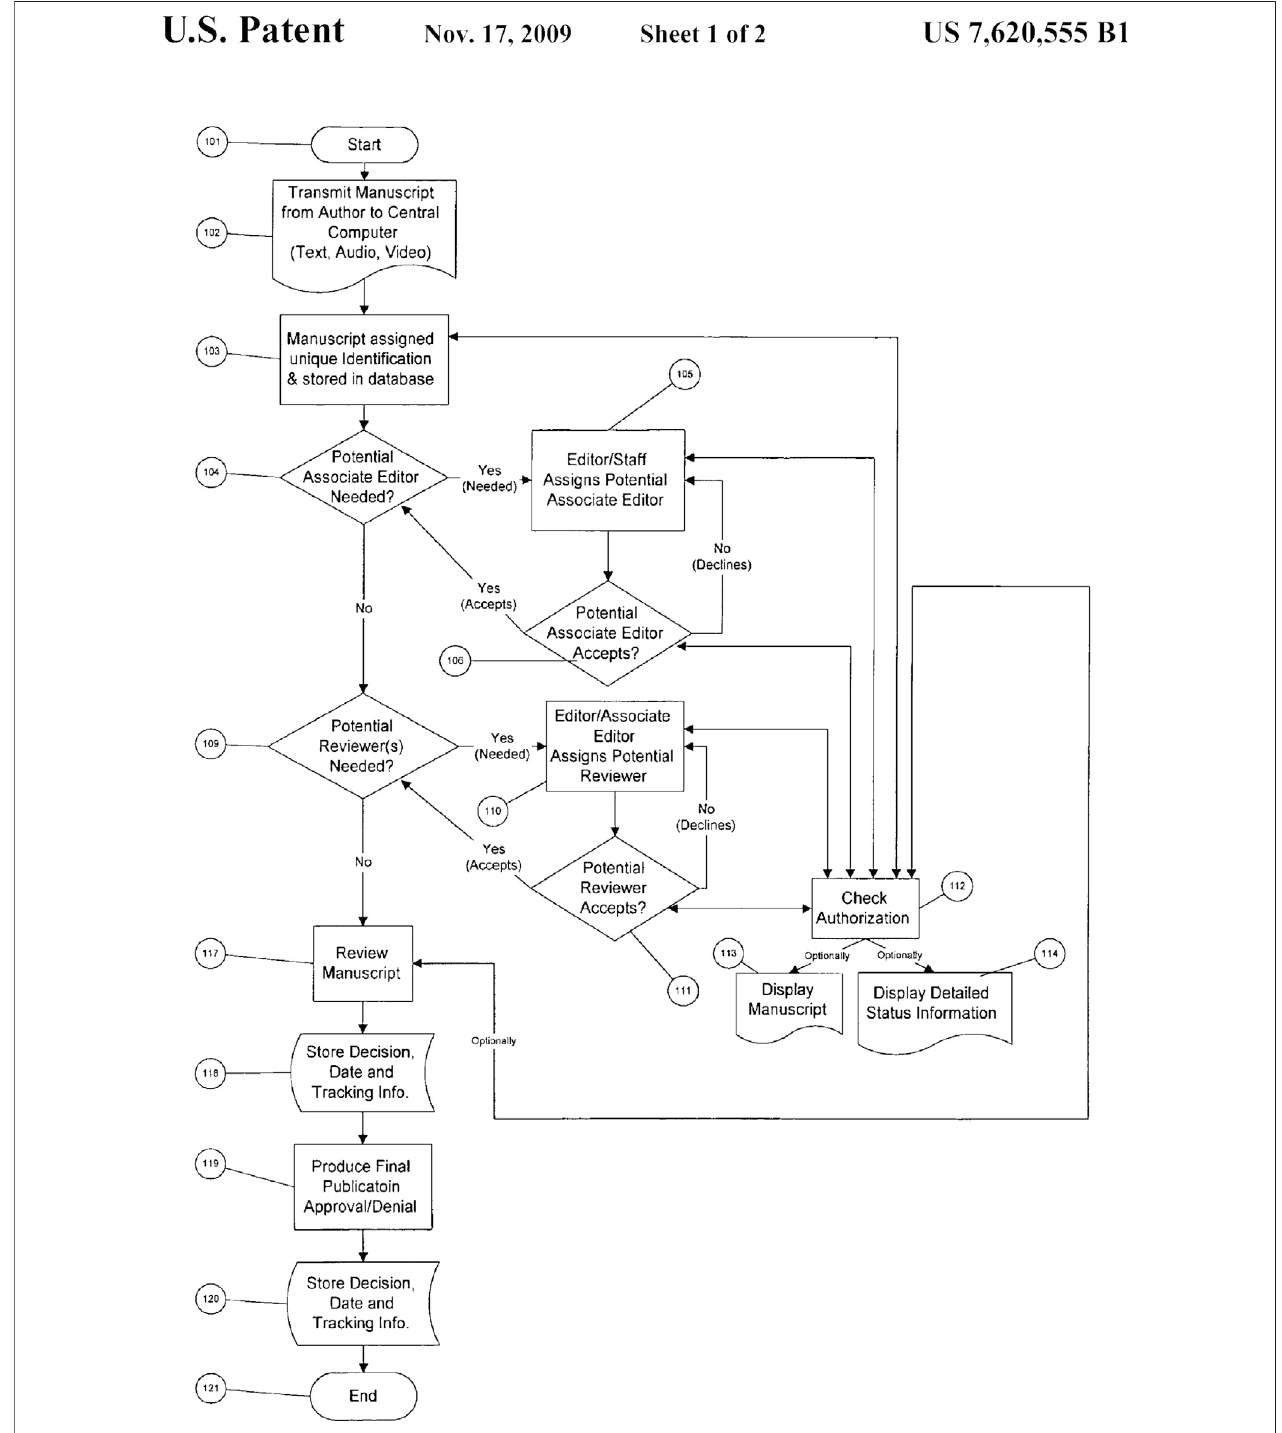
FIGURE 3 | The editorial process as depicted in the patent (from: Plotkin (2009)).